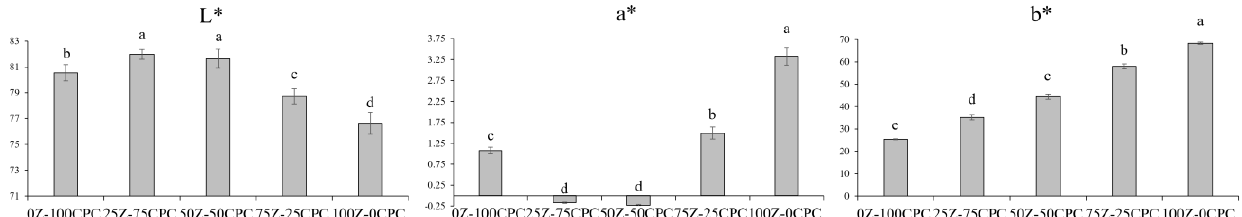
Figure 1. Colour space values ( L* a* b* ) of plant-based cheese alternative samples. Different letters (a–e) indicate significant differences between samples ( p < 0.05).